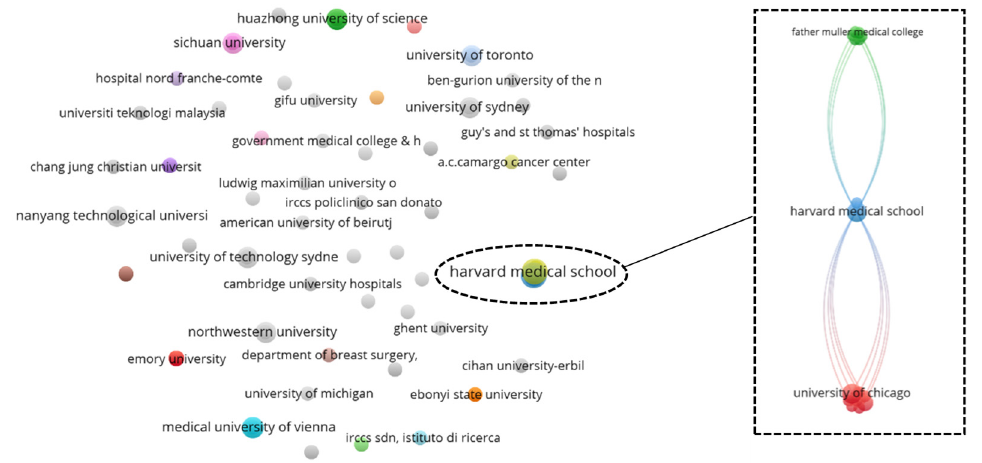
Figure 11. Co-authorship bibliographic network analysis: affiliation.